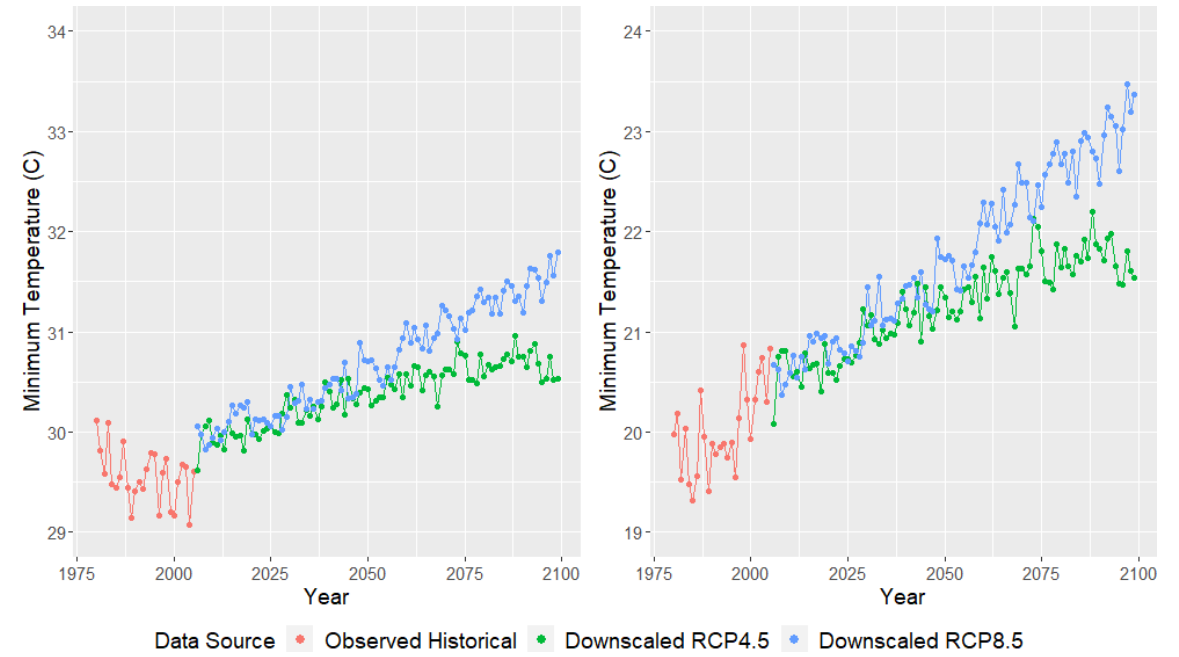
Figure C1. Mean daily maximum (left panel) and minimum (right panel) temperature ( ◦ C) as a function of year. Observed historical GHCN data from 1980–2005 are plotted in red, while downscaled RCP4.5 and RCP8.5 temperatures (from the UK’s HadGEM2) from 2006–2100 are plotted in green and blue, respectively. This figure was created using Wickham (2016).